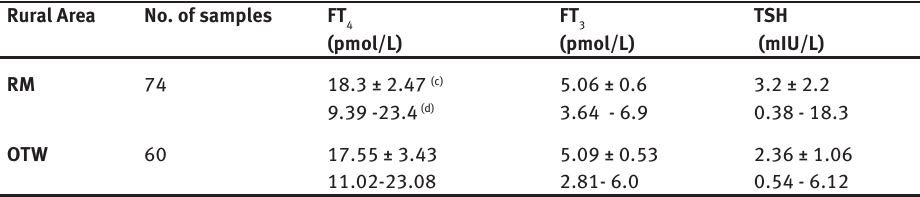
, FT and TSH Concentration in Serum of Children from RM and OTW. Table 2: FT 4 3 Rural Area